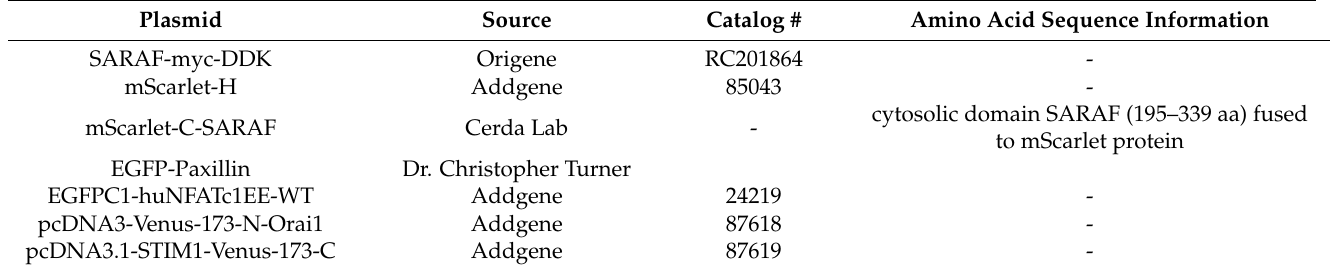
Table 1. Plasmids.